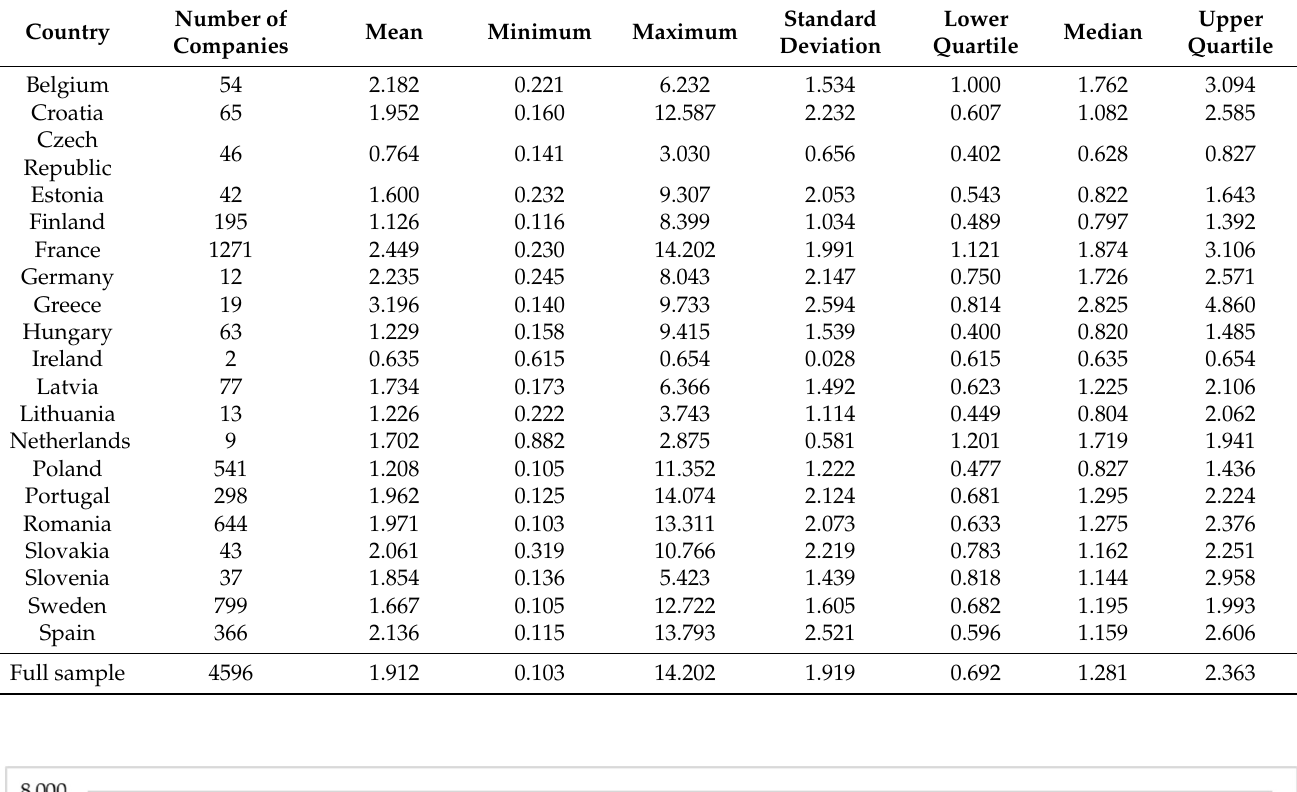
Table A1. Descriptive statistics of TD/SF by country of company headquarters, full sample, 2011–2019.